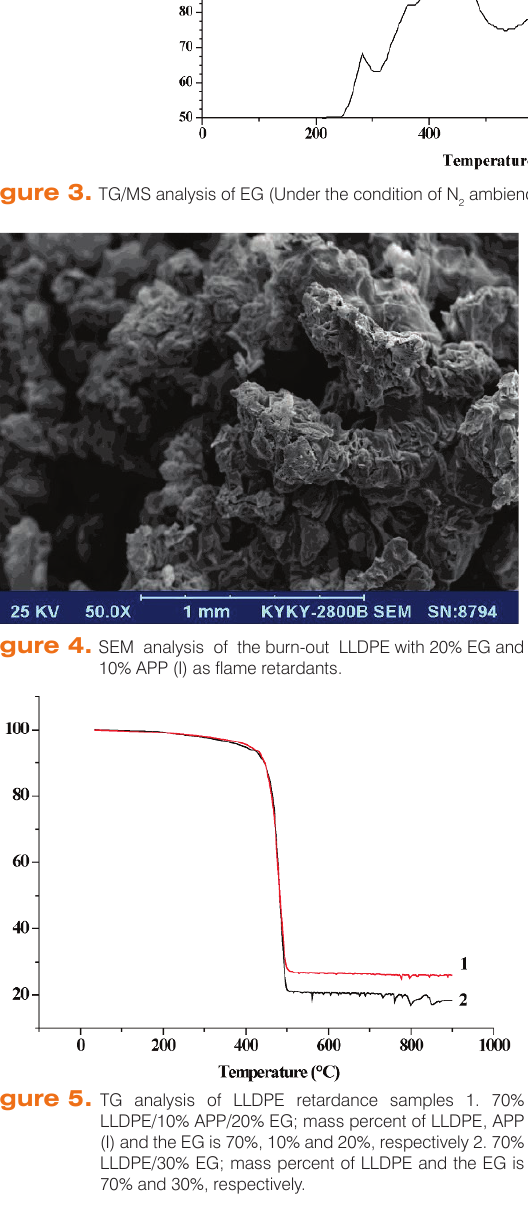
Figure 5. TG analysis of LLDPE retardance samples 1. 70% LLDPE/10% APP/20% EG; mass percent of LLDPE, APP (I) and the EG is 70%, 10% and 20%, respectively 2. 70% LLDPE/30% EG; mass percent of LLDPE and the EG is 70% and 30%,